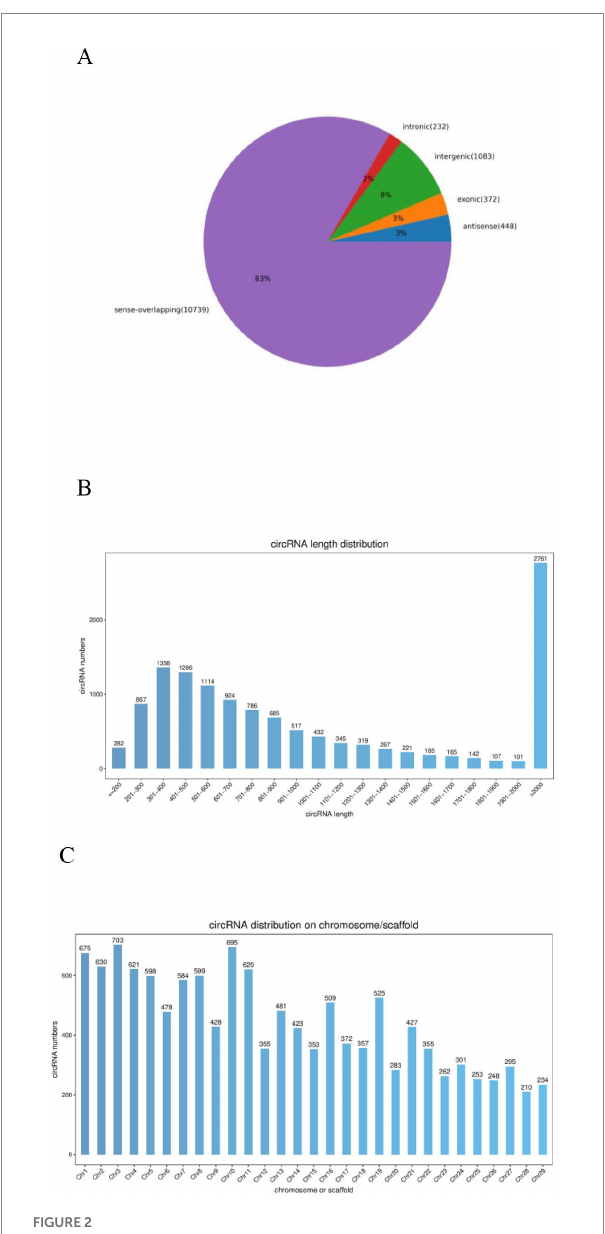
FIGURE 2 Qianbei Ma Goat testicular circRNAs. (A) CircRNAs from distinct genomic sites. (B) Length distributions of the known circRNAs. (C) Chromosome distribution map of